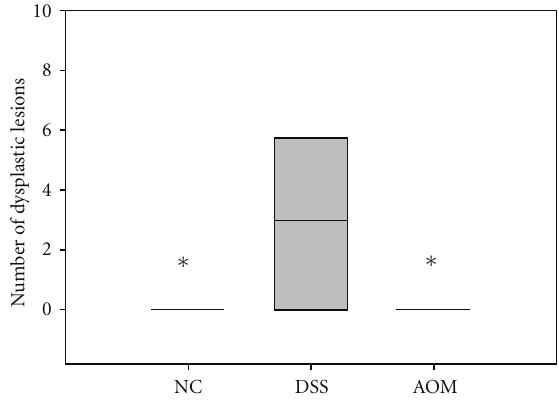
Figure 9: Number of dysplastic lesions in colon classified as low- grade dysplasia in di ff erent treatment groups. DSS 3.0 (0.0–5.5); AOM 0.0; NC 0.0. ∗ Denotes P < 0 . 05 compared to the DSS group.